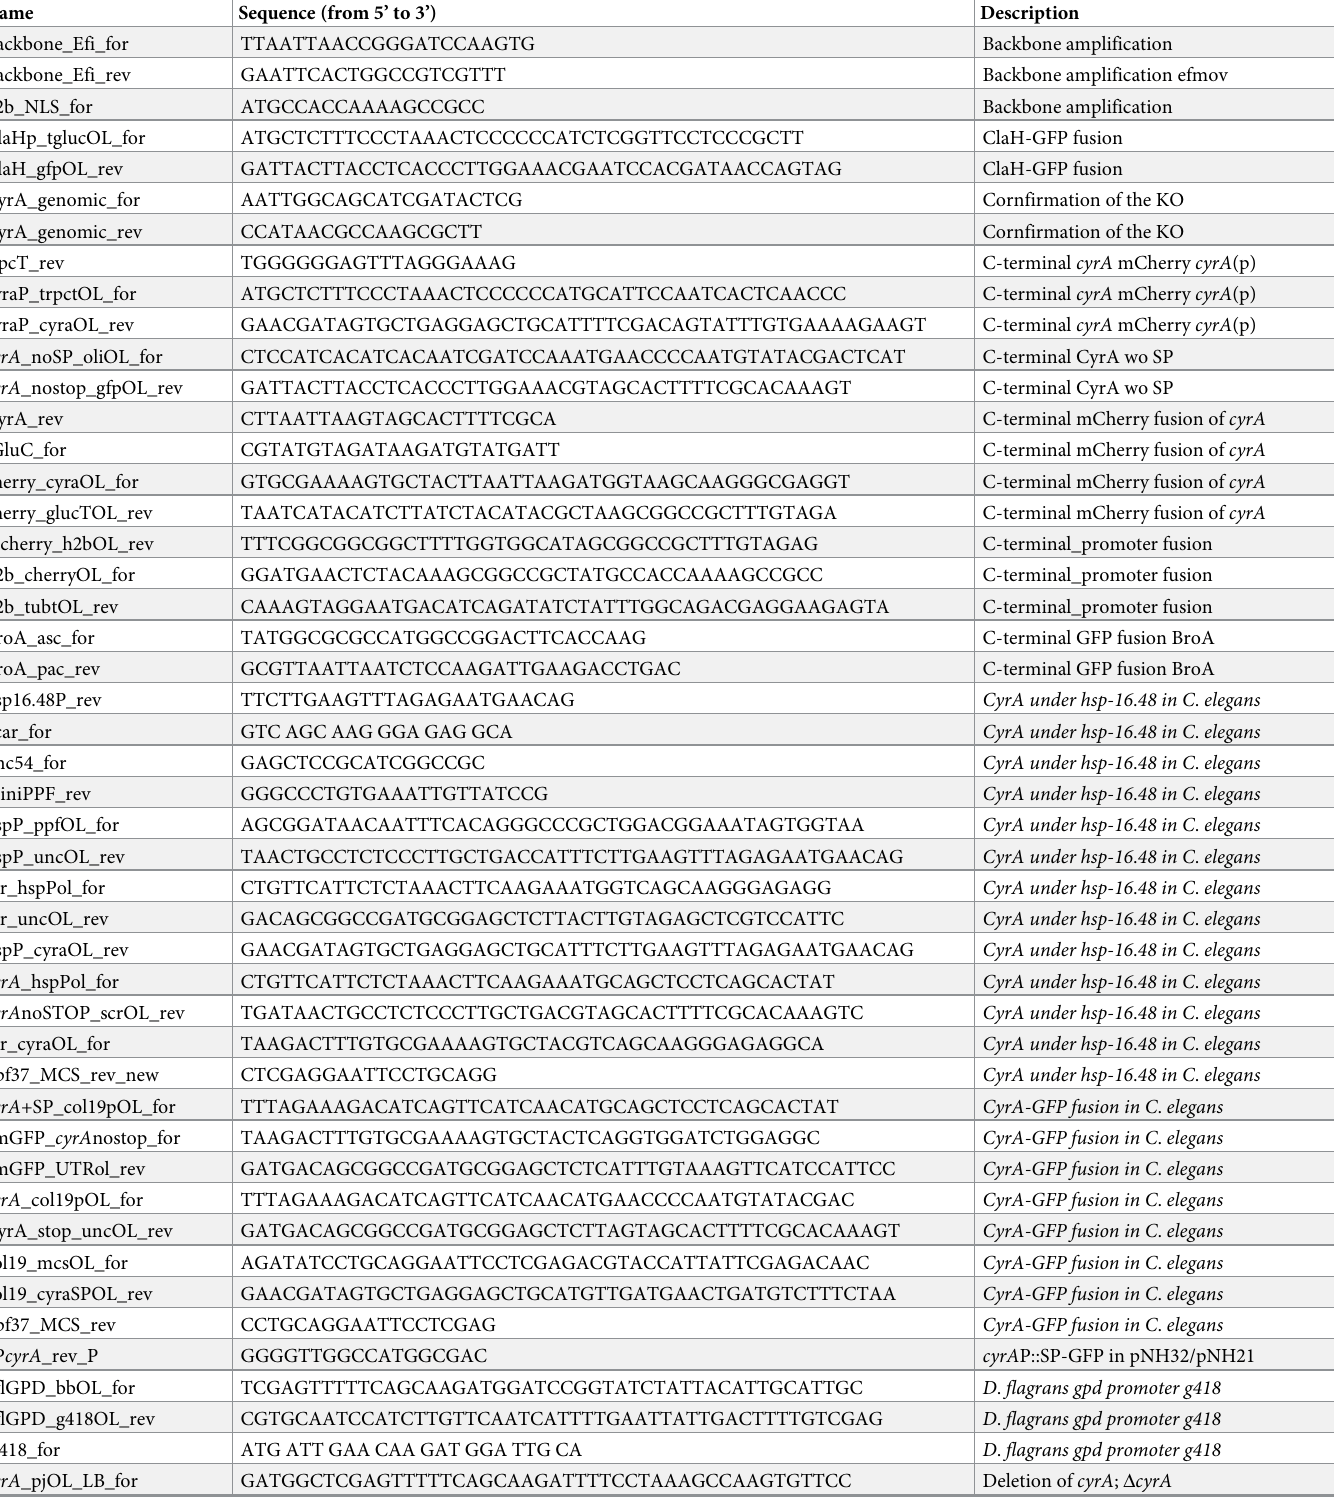
Table 3. Oligonucleotides used in this